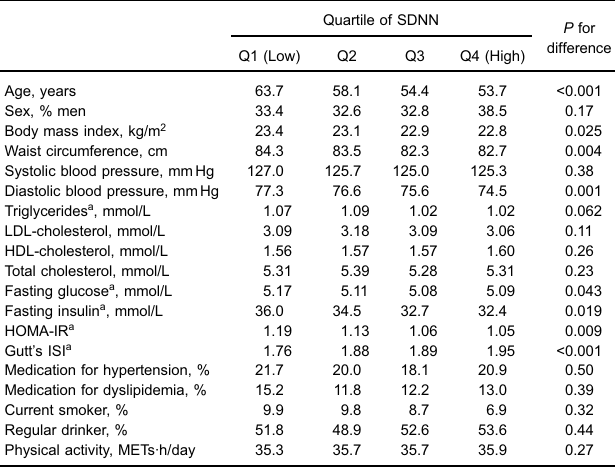
Table 2. Sex- and age-adjusted means a grouped according to quartiles of SDNN ( n = 1899) Age, years